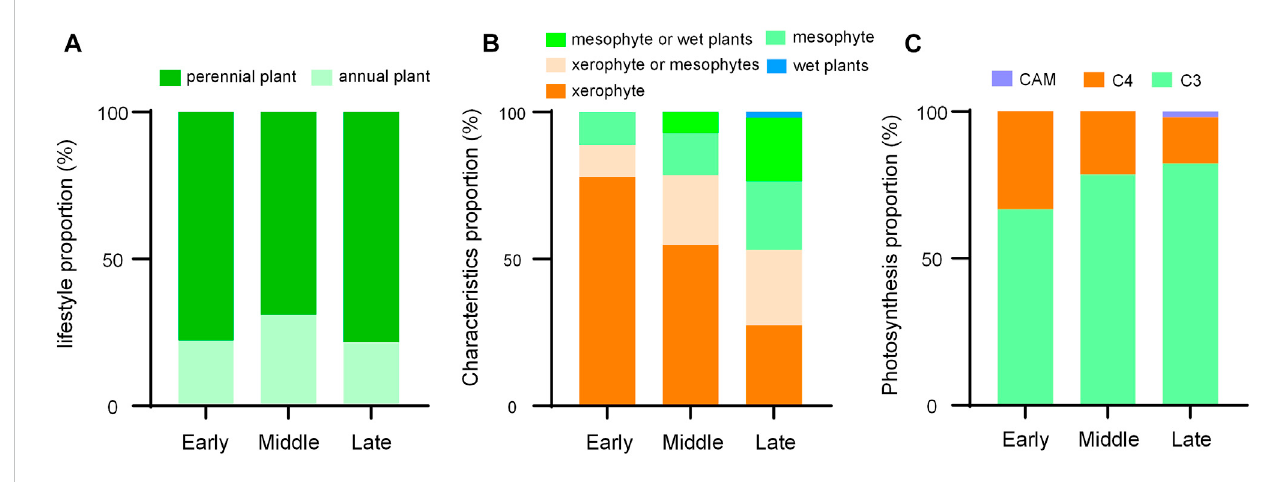
FIGURE 2 Species composition differences in different stages of restoration. CAM, Crassulacean acid